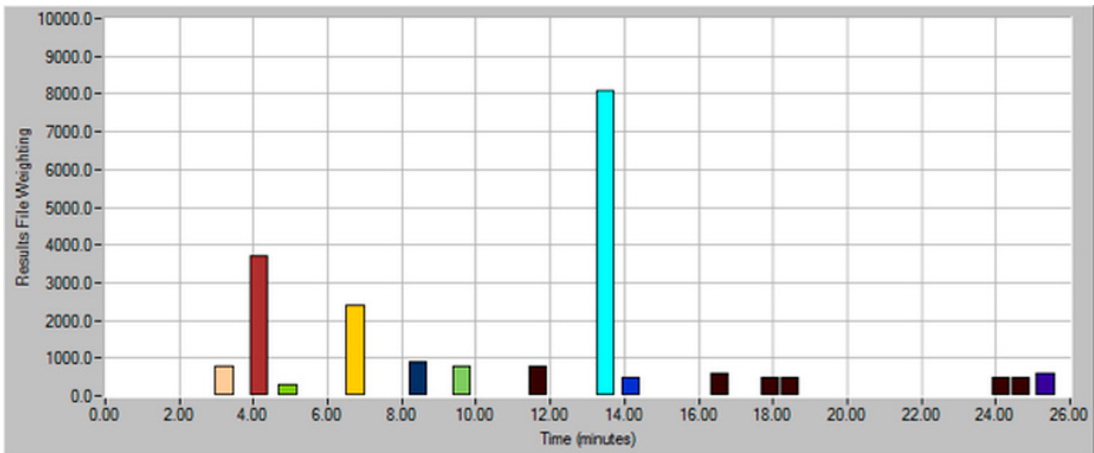
Figure 4. Aroma dilution analysis plot of wine made from Marquette grapes harvested at 22° Brix. The compound most impactful in the total aroma of this sample occurred at 13.3 min (light blue bar), assigned odor dilution number 8, and simultaneously identified using a mass spectrometer as ethyl hexanoate.